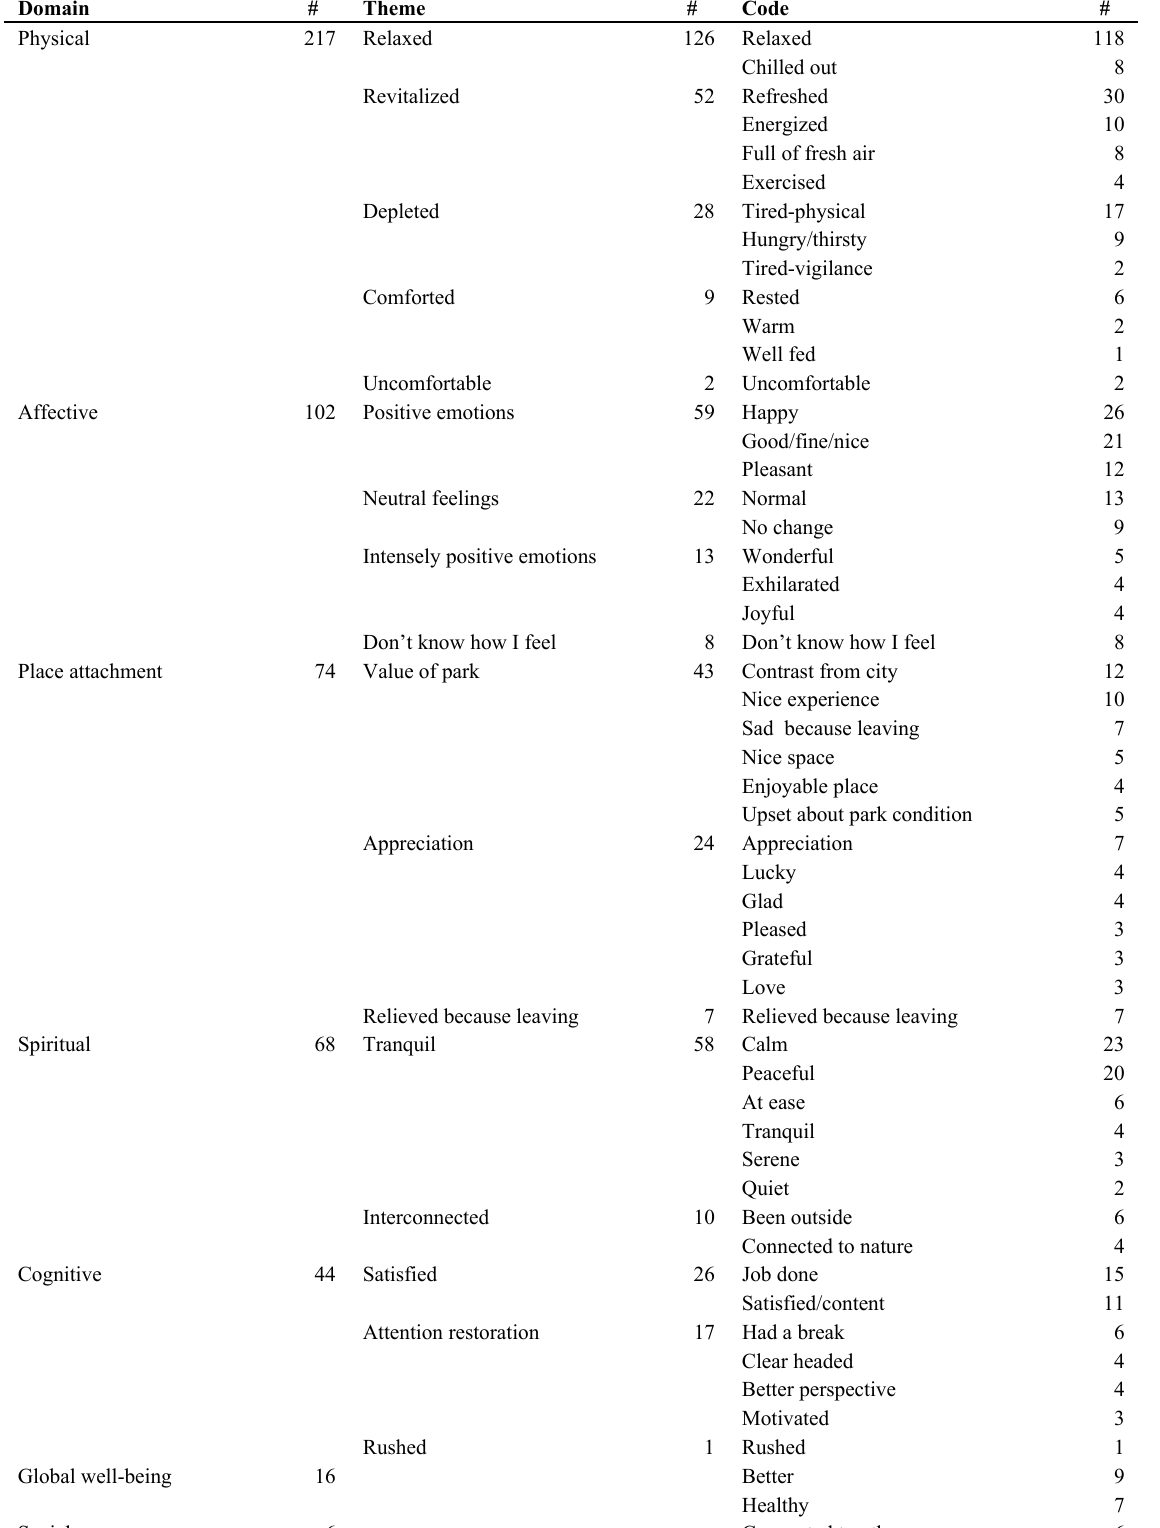
Table 2. Participant specified derived effects following green space use (N = 527 comments). Park users, in situ , answered the question, “Thinking about after you leave this park, what words would you use to describe how you feel after you leave here?” Codes, themes, and domains are identified along with the number of comments within each. Comments included in the analysis were from individuals who had visited the given green space